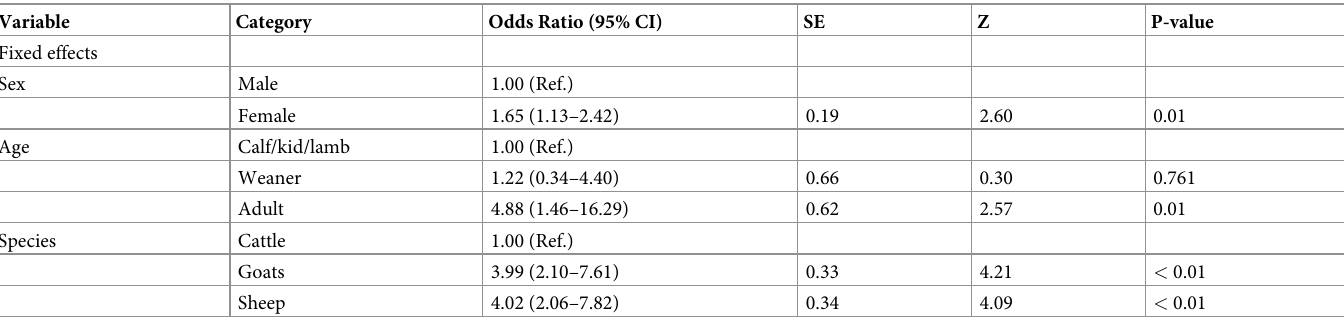
Table 4. Variables found to be associated with C . burnetii seropositivity in livestock using multivariable mixed-effects logistic regression model.